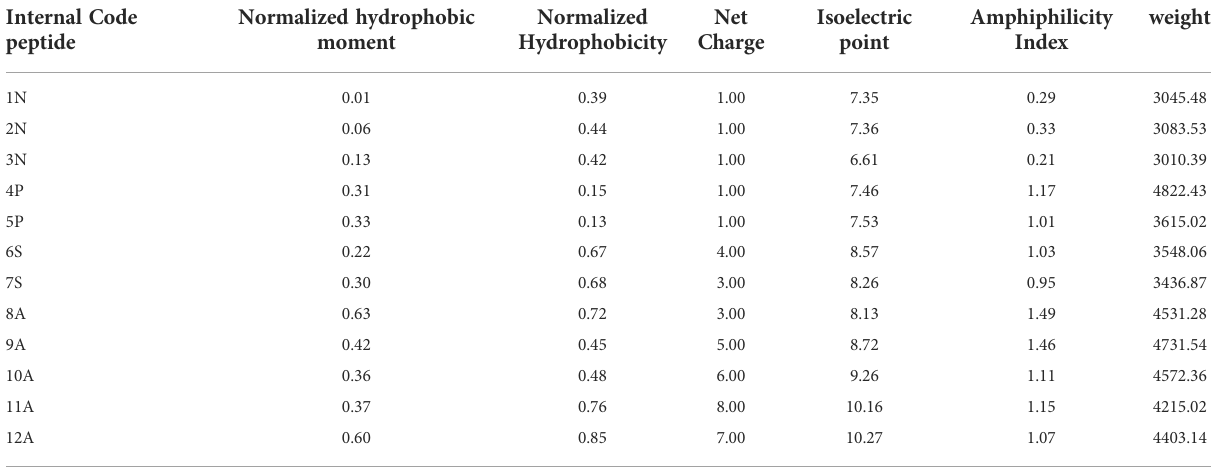
TABLE 3 Physicochemical characteristics of putative AMPs in cnidarians. Internal Code